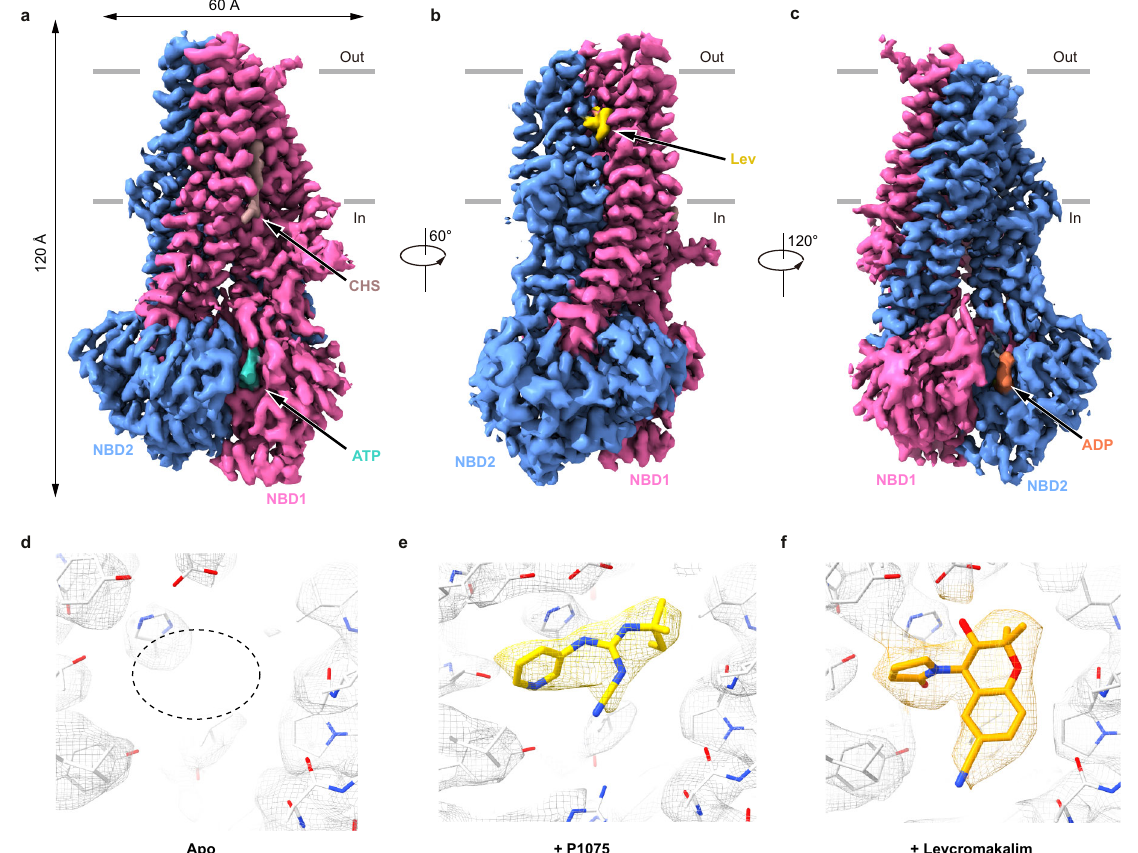
Fig. 1 Structure of the SUR2 subunit in complex with K ATP opener and Mg-nucleotides. a – c Cryo-EM density map of SUR2B in complex with Mg- nucleotides and levcromakalim (Lev), viewed from the side. The approximate position of the lipid bilayer is indicated by gray bars. TMD1-NBD1, TMD2- NBD2, Lev, Mg-ATP, Mg-ADP, and cholesteryl hydrogen succinate (CHS) are colored in pink, blue, yellow, cyan, orange, and brown, respectively. For better visualization of the position of Lev, a fragment of TMD2 in front of Lev was omitted in ( b ); the residual detergent densities are also omitted. d Empty K ATP opener-binding site in the cryo-EM map of the SUR2B subunit in complex with Mg-nucleotides is outlined by dashed lines. The map is shown as mesh and the protein is shown as sticks. e P1075 density (yellow) in the SUR2B subunit (gray). f Lev density (orange) in the SUR2B subunit